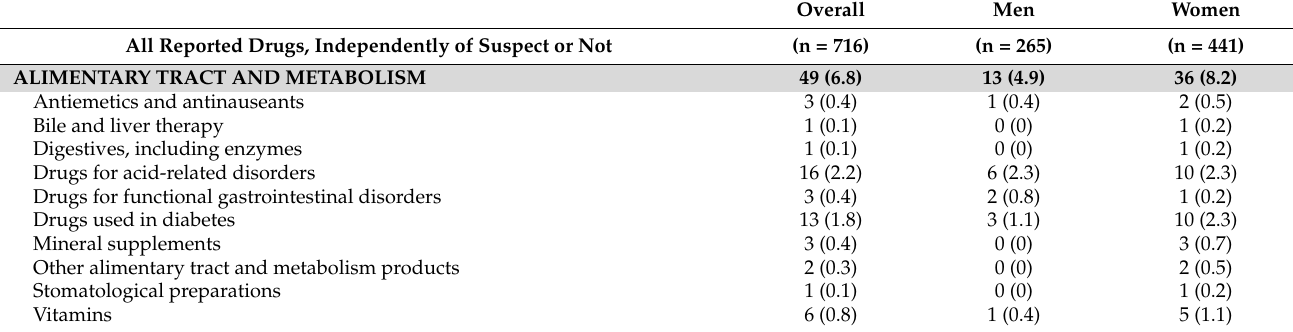
Table 4. All reported drugs, independently of being suspect or not. Information from 297 patients, who can contribute more than one drug